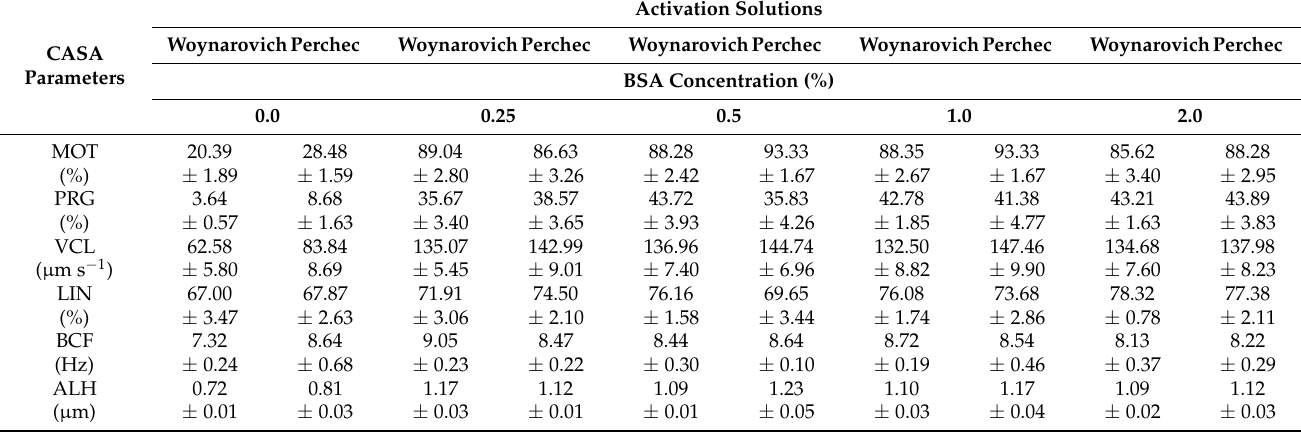
Table 2. Detailed characteristics (mean ± SEM) of CASA parameters after ide ( Leuciscus idus , n = 5) sperm motility activation with Woynarovich and Perchec solutions supplemented with different BSA